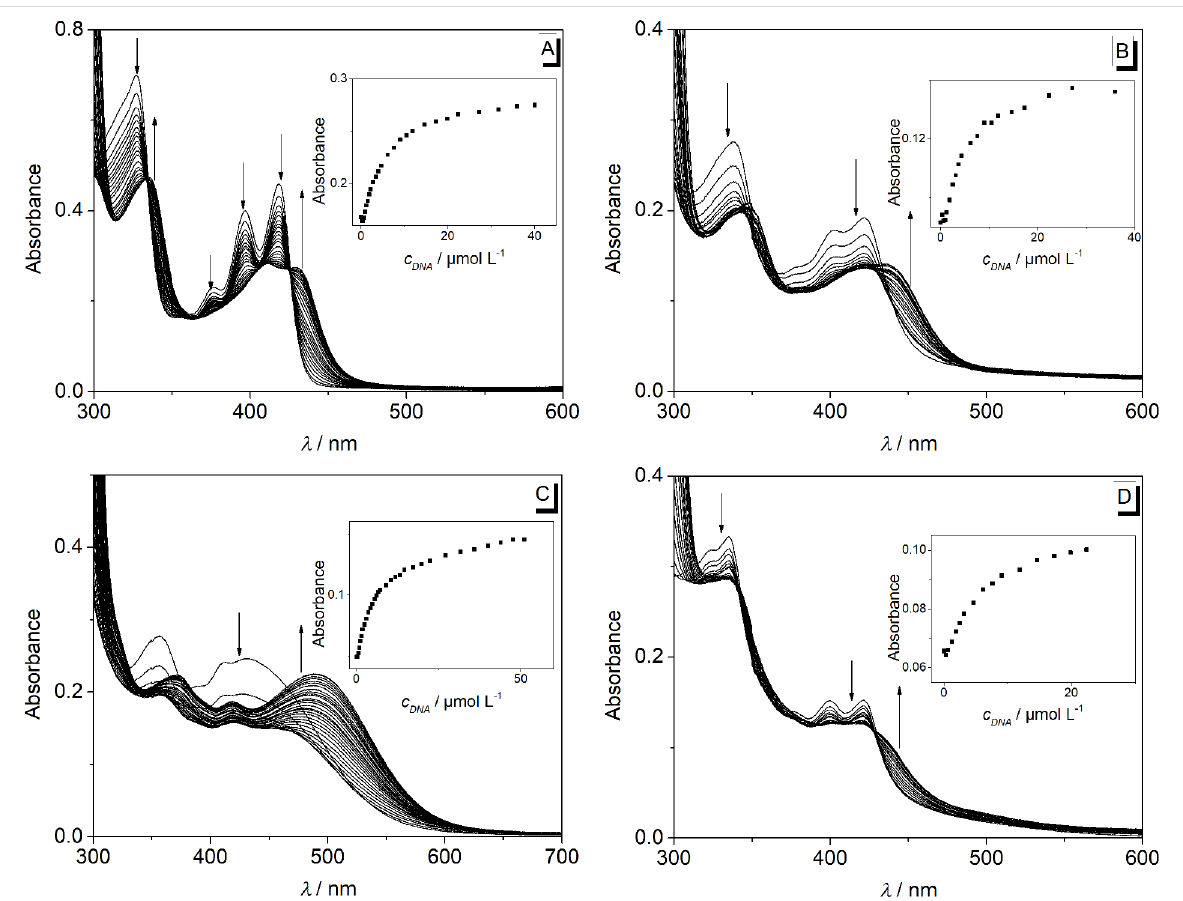
Figure 7: Photometric titration of 2a (A), 2b (B), 2c (C) and 2d (D) with 22AG in potassium phosphate buffer (95 mM K + ; 5% DMSO; pH 7.0); c L = 20.0 μ M. Arrows indicate the development of bands with increasing DNA concentration. Inset: Plot of the absorption at long wavelength versus DNA